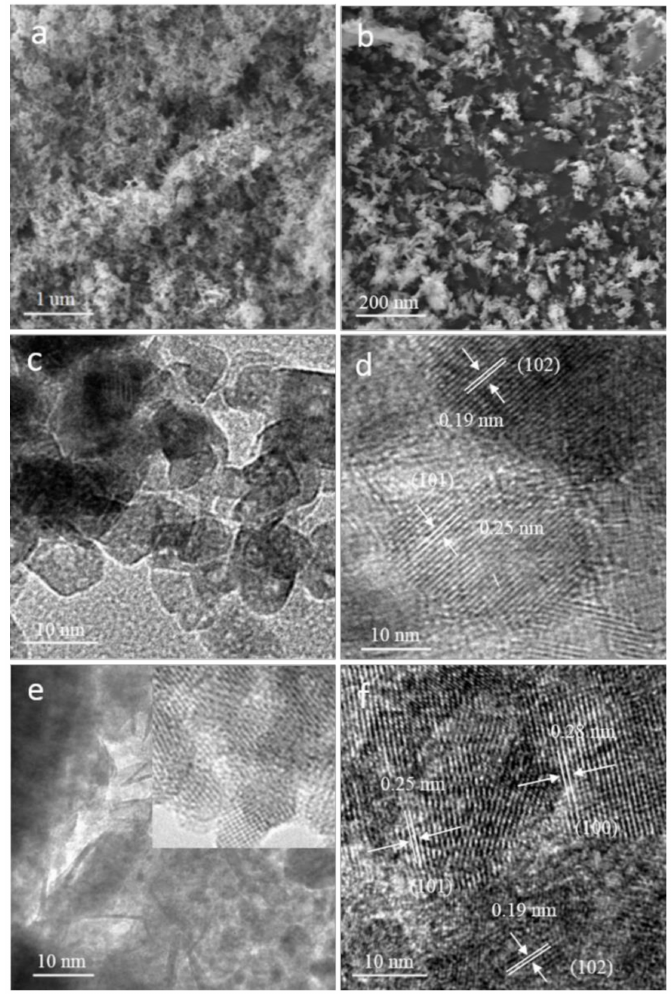
Figure 2. SEM images of ( a ) ZnO, ( b ) ZnO/rGO. TEM images of ( c ) ZnO and ( e ) ZnO/rGO. HRTEM images of ( d ) ZnO and ( f )